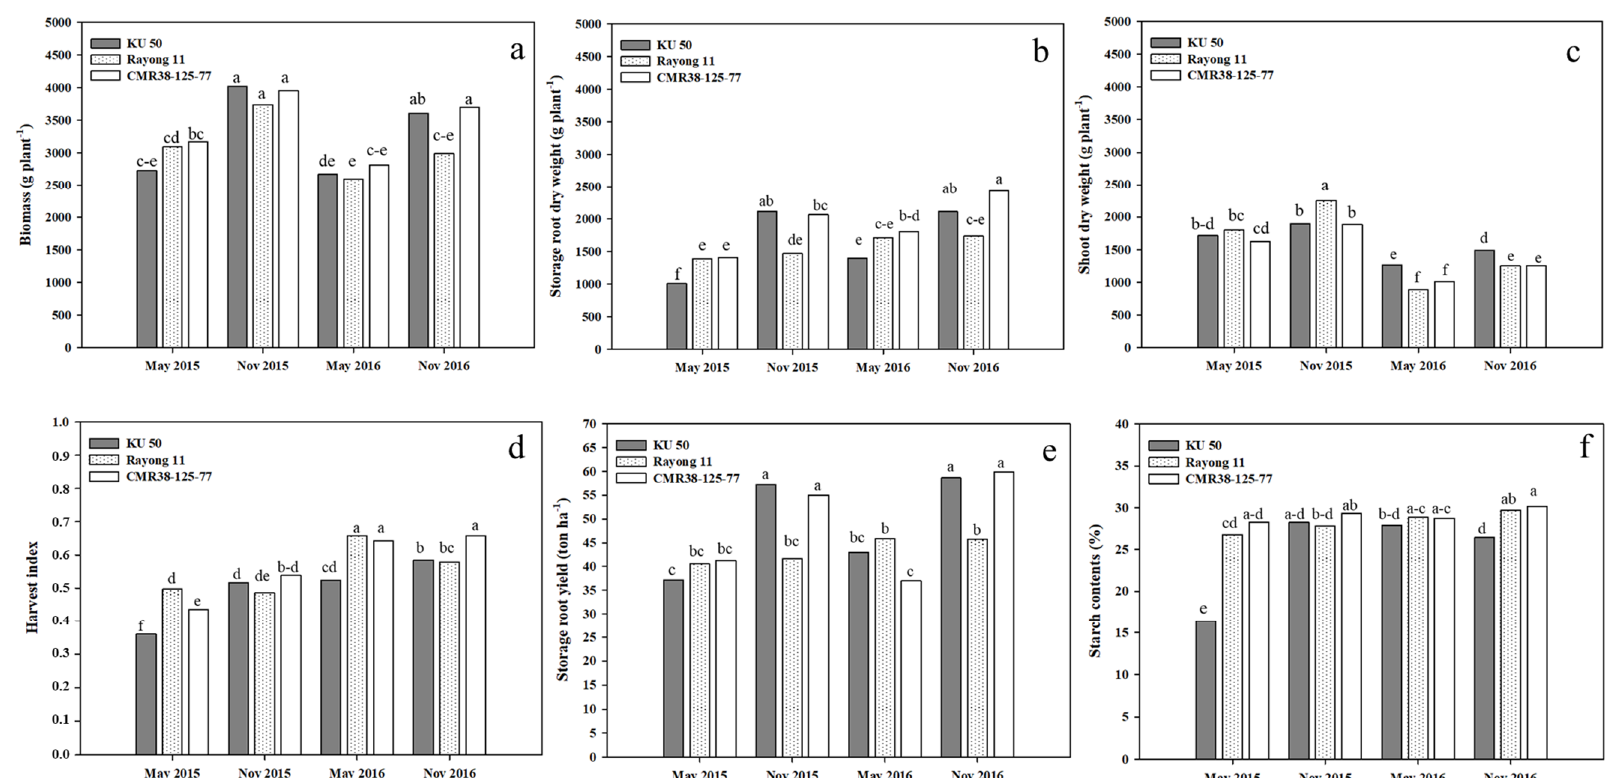
Figure 2. Biomass ( a ), dry weight (DW) for storage root ( b ) and shoot ( c ), harvest index (HI) ( d ), storage root yield ( e ) and starch content ( f ) of three cassava genotypes at harvest (12 months after planting) when planted in May and November in 2015 and 2016. The same letters in each genotype are not significantly different by least significant difference ( p < 0.05).